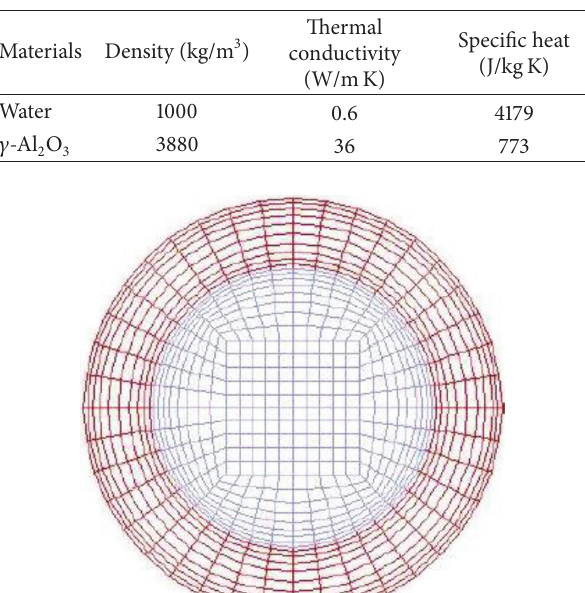
Table 1: Thermophysical properties of material under considera- tion.